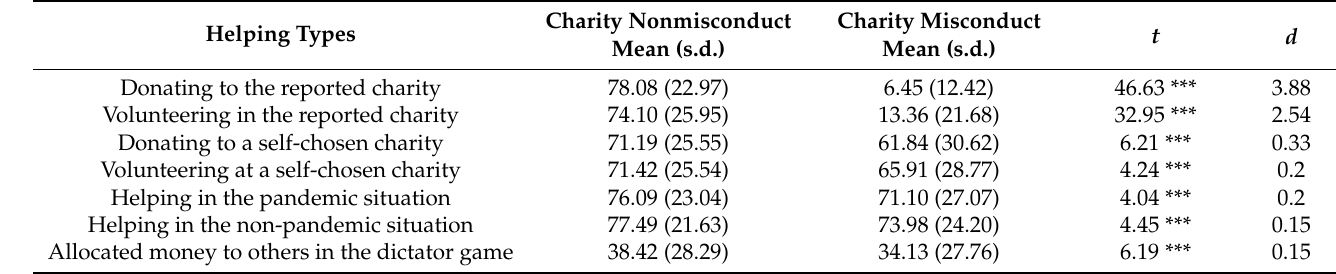
Figure 4. Results in Study 3. Reading news on charity misconduct significantly decreased participants’ willingness to provide help: donating to the reported charity, volunteering in the reported charity, donating to a self-chosen charity, volunteering at a self-chosen charity, helping in a pandemic situation, and a non-pandemic situation. Participants allocated less money to the other partner in a dictator game. Error bars: SD. Table 1. Results in Study 3.